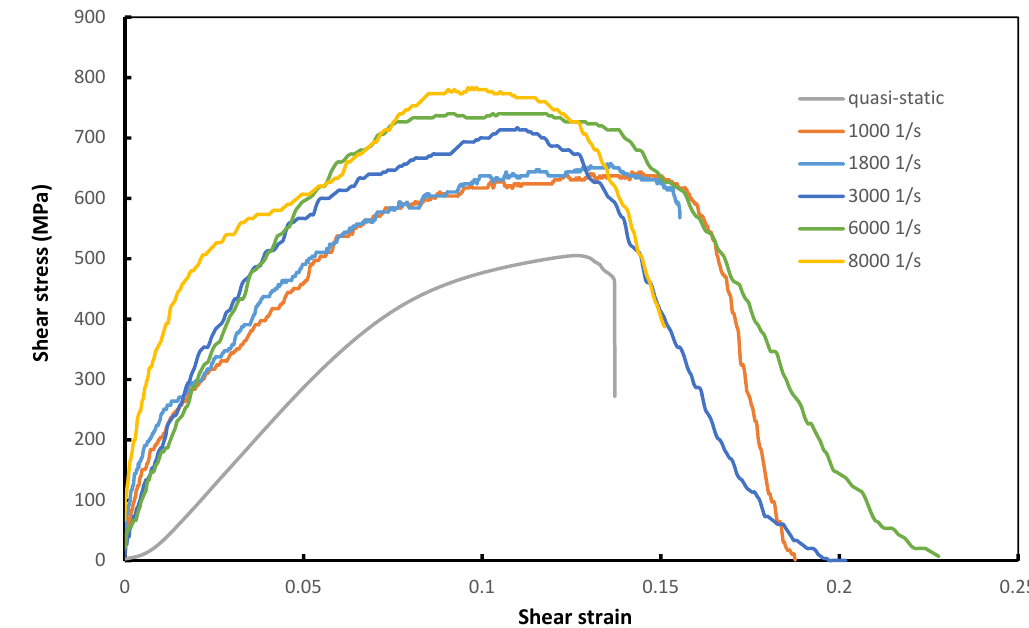
Figure 10. Shear stress–strain curves of Ti6Al4V with NSSS under different strain rates.